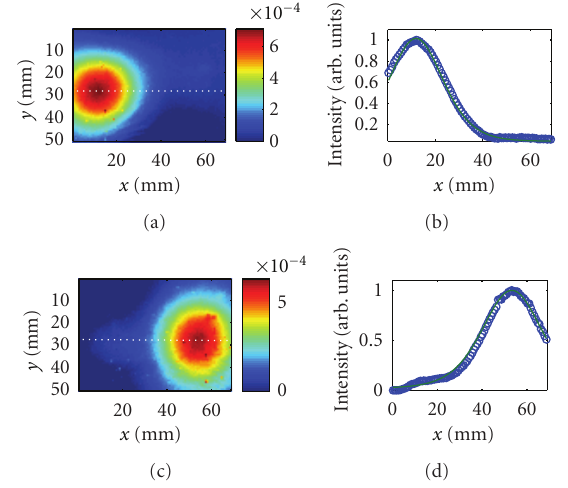
Figure 12: NCIDs on the detector plane are shown in (a) and (c); corresponding Green’s function fits to the horizontal spatial profiles through the dashed line are shown in (b) and